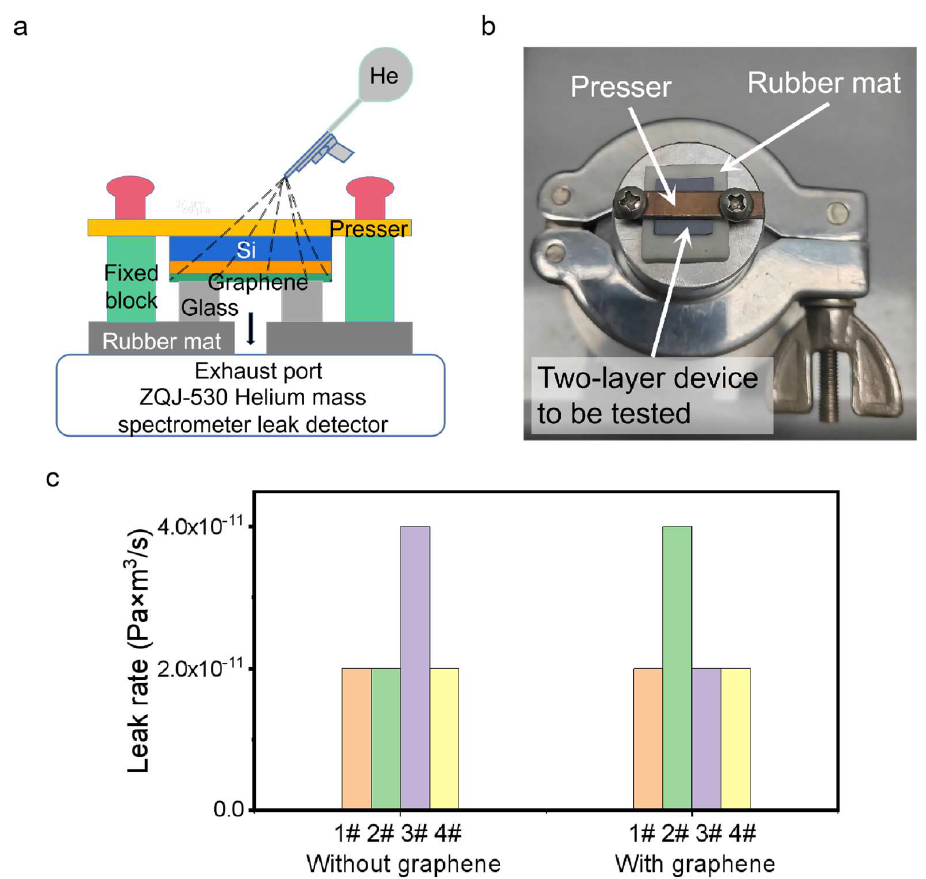
Figure 3. Sealing performance of two-layer device. ( a ) Schematic of a helium mass spectrometer leak detector; ( b ) A photograph of the helium mass spectrometer leak detector; ( c ) Comparison of leak rates between devices without and with graphene (each colored bar represents one device).